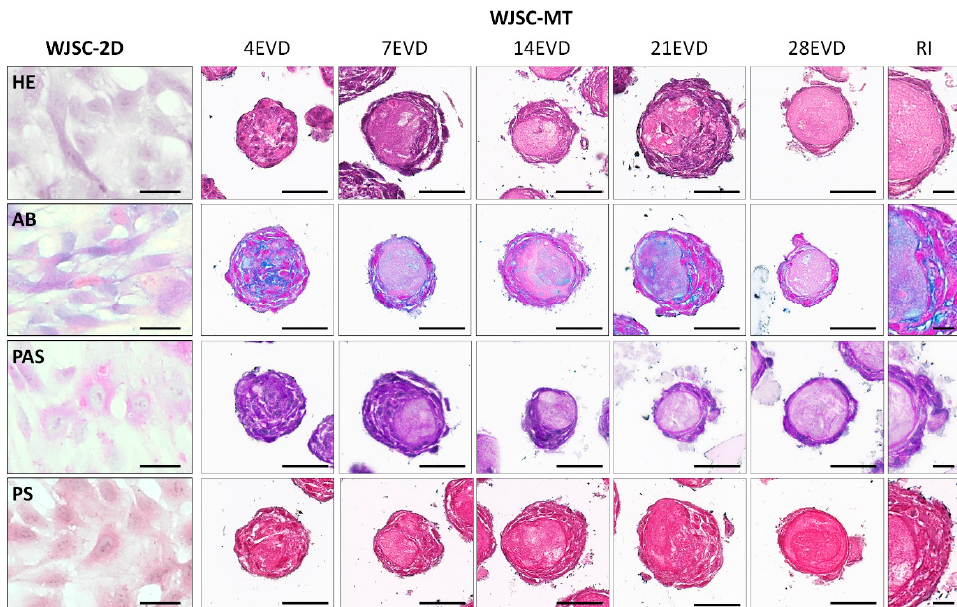
Figure 5. Histochemical analyses of WJSC cultured under two-dimensional (WJSC-2D) and three- dimensional microtissue (WJSC-MT) culture methods at different days of ex vivo development (EVD). Hematoxylin–eosin (HE), Alcian Blue (AB), Periodic Acid-Schiff (PAS) and Picrosirius Red (PS) methods were applied to analyze general morphology and synthesis of specific ECM compo-nents in WJSC-2D and WJSC-MT at 4, 7, 14, 21 and 28 days of EVD. Representative images (RI) at higher magnification are shown on the right. Scale bar: 50 µm and 25 µm (RI).